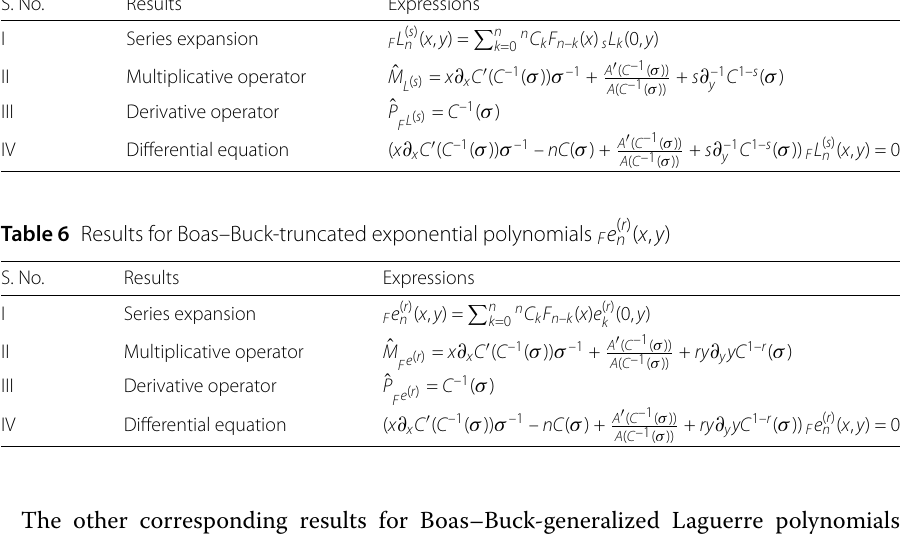
Table 5 Results for Boas–Buck-generalized Laguerre polynomials F L ( s ) n ( x , y ) S. No.